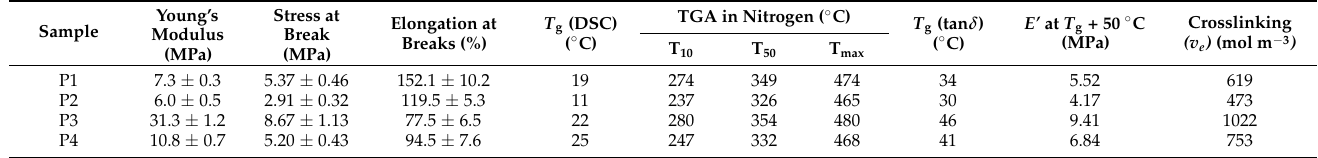
Figure 4. ( a ) Stress–strain curve, ( b ) DSC curve, ( c ) TGA curve and ( d ) DMA curve of the films. Table 3. Mechanical and thermal properties of the films.